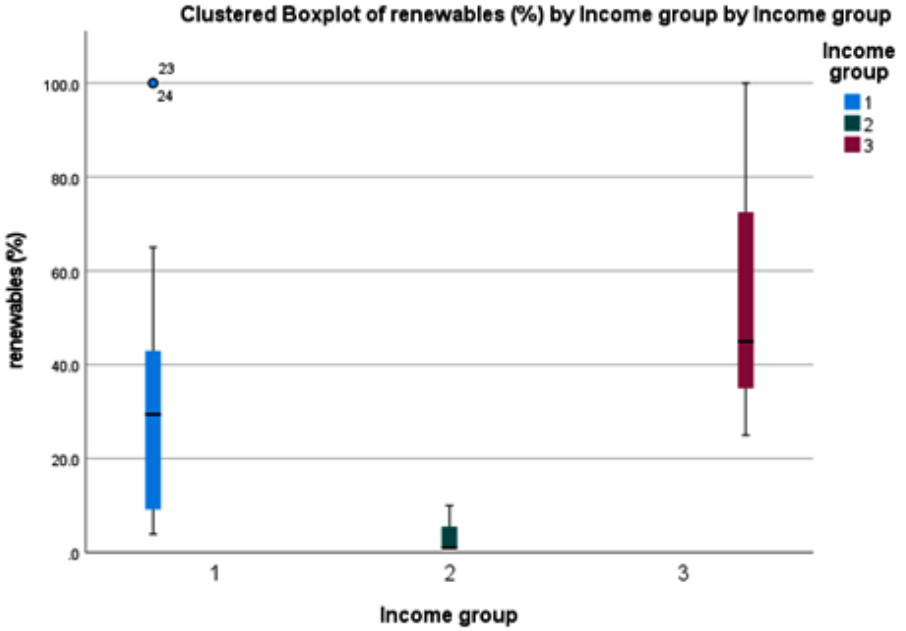
Figure 1. Span chart, compiled by the authors of the study.